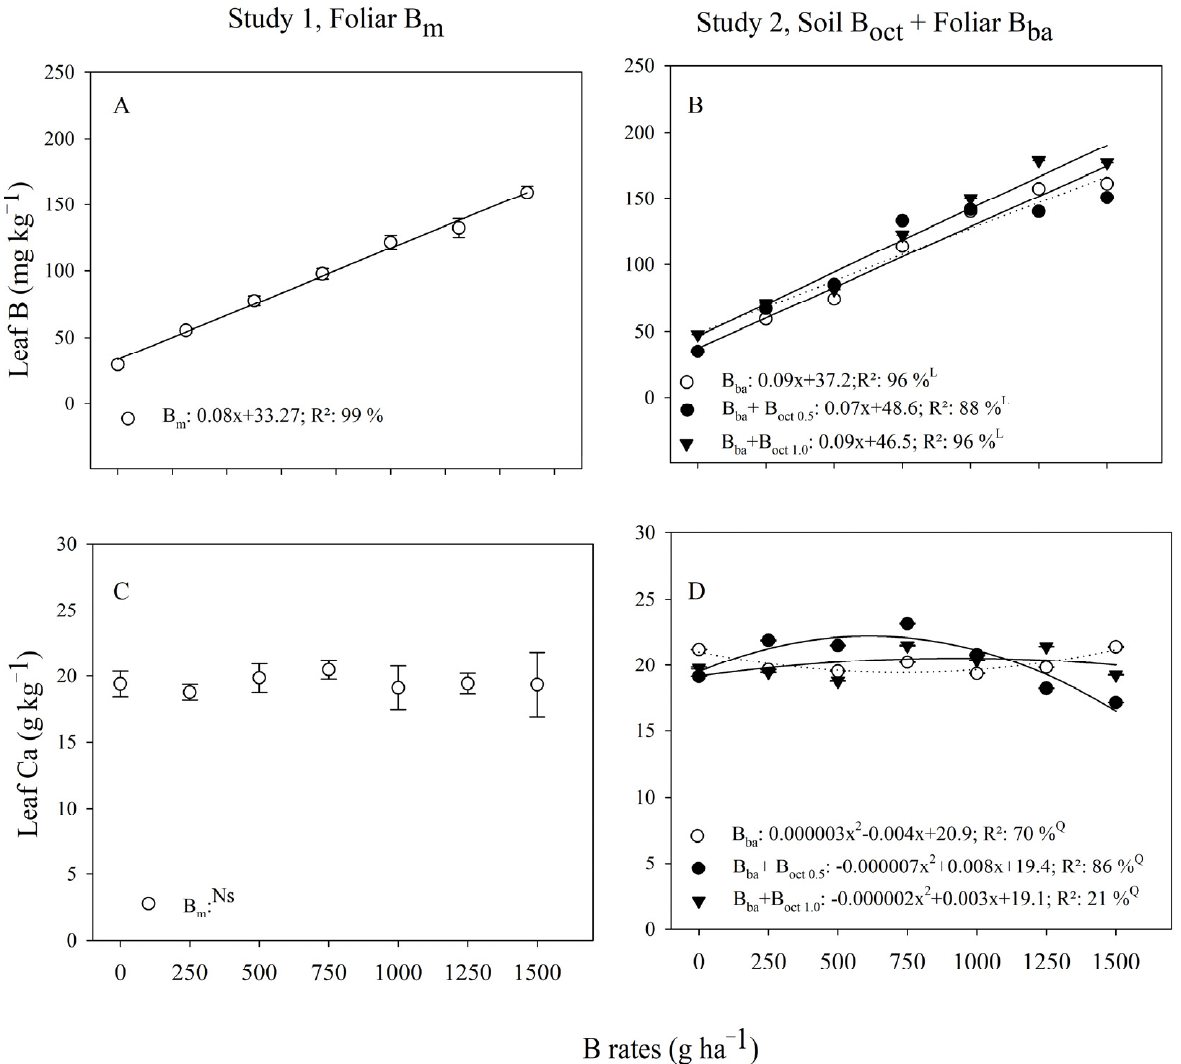
Figure 4. Leaf boron (mg kg − 1 ; A , B ) and leaf calcium (g kg − 1 ; C , D ) in Study 1 with foliar application of B (Bm, monoethanolamine) using six B rates (250, 500, 750, 1000, 1250 and 1500 g ha − 1 ), and in Study 2 with B application in soil using sodium octaborate (Boct) with two rates (Boct0.5: 0.5 kg ha − 1 ; and Boct1.0: 1.0 kg ha − 1 ), and the foliar B application using boric acid (Bba) with six rates (250, 500, 750, 1000, 1250, and 1500 g ha − 1 ). L and Q: linear and quadratic models, respectively. Averages presented with error variation. Boct0.5 = sodium octaborate at 0.5 kg ha − 1 ; Boct1.0 = sodium octaborate at 1.0 kg ha − 1 .